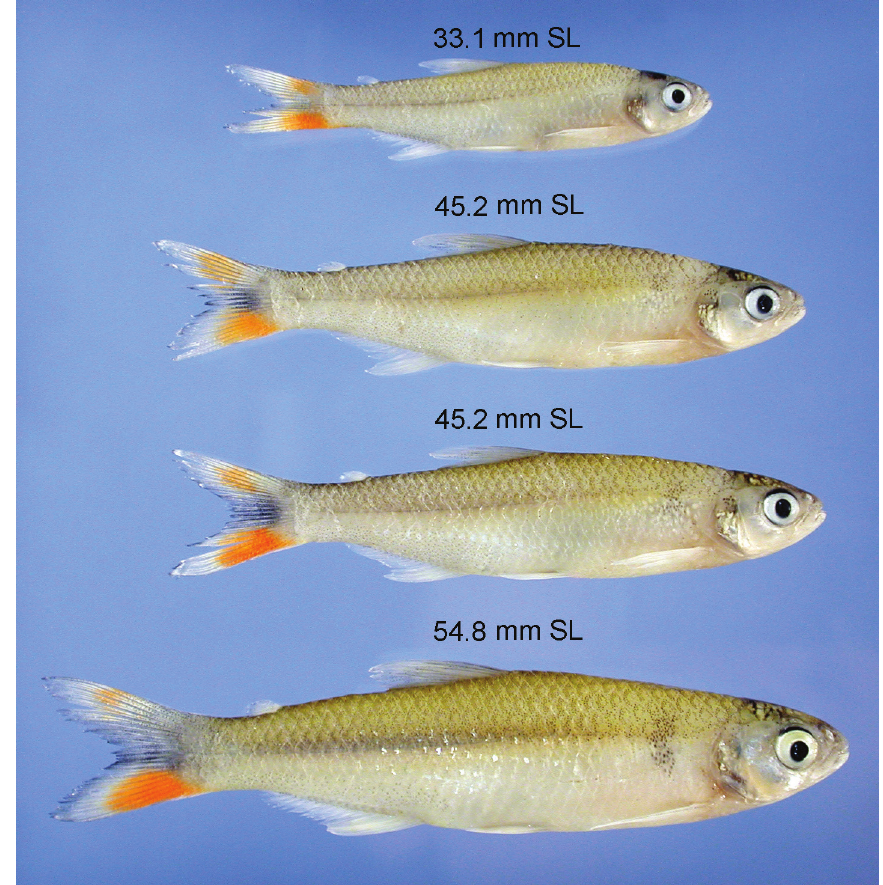
Figure 3. Recently preserved specimens of Aphyocharax pusillus : ANSP 178013, 4, 33.1–54.8 mm SL, Peru, Loreto, Rio Napo (Amazon river basin), right bank just upstream from mouth of Mazan river, near town of Mazan (3°29'10"S, 73°6'24’’W). Photo- graphed by Mark Sabaj